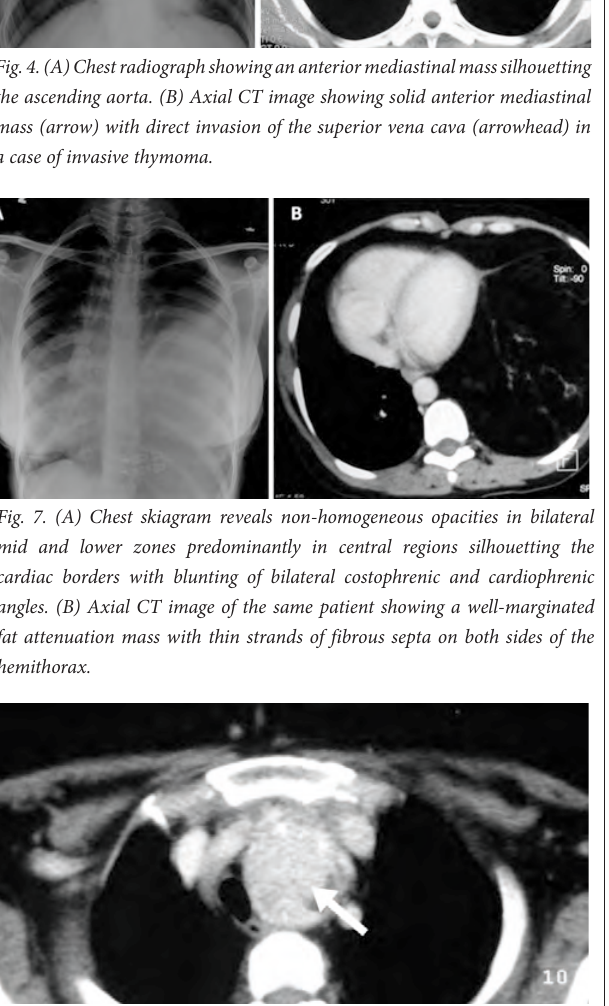
Fig. 8. Axial CT image in a patient with Cushing’s syndrome showing ectopic thymic neuroendocrine tumour